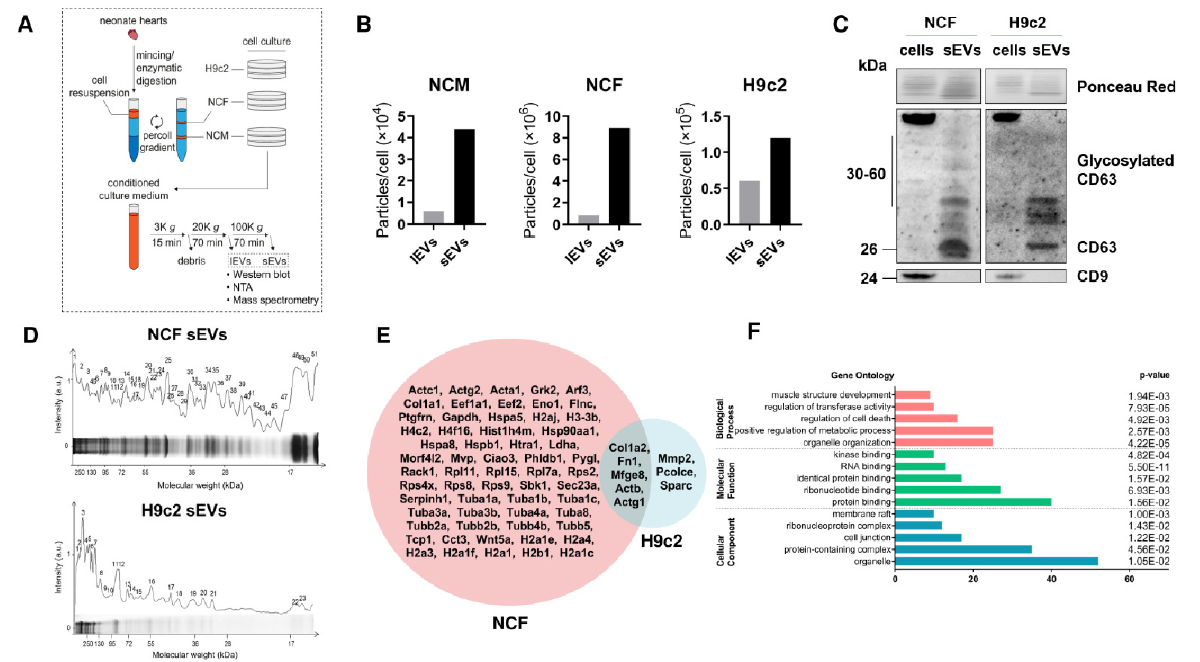
Figure 1. Proteomic analysis of cardiac cells-derived small EVs. ( A ) Isolation procedure of rat cardiac cells and their corresponding EVs. Neonate cardiac myocytes (NCM) and fibroblasts (NCF) isolated from ventricles of 1–3 day old Wistar rats, and cardiomyoblasts H9c2 were cultured in serum-free media for 96 h. Differential ultracentrifugation was used to isolate large (lEVs) and small EVs (sEVs) from conditioned culture medium. K: ×1000. ( B ) Nanoparticle tracking analysis (NTA) measurement of particle concentration in lEV and sEV pellets normalized to the number of producing cells in NCM, NCF, and H9c2 cells. Details are shown in Figure S1. ( C ) Ponceau Red and Western blot of cells and corresponding sEVs to detect exosomal markers CD63 and CD9. ( D ) Coomassie blue staining of gel separated NCF (75 µg) and H9c2 (25 µg) sEV proteins. Highly stained bands (labeled with a number) were used for MALDI-TOF/TOF mass spectrometry (MS). ( E ) Venn diagram representation of sEV proteins detected by MS in NCF (pink) and H9c2 (blue) sEVs. Protein abbreviations are detailed in Table S1 ( F ) GO (Gene Ontology) analysis of enriched GO terms for biological process, molecular function, and cellular component. p values were FDR-adjusted.